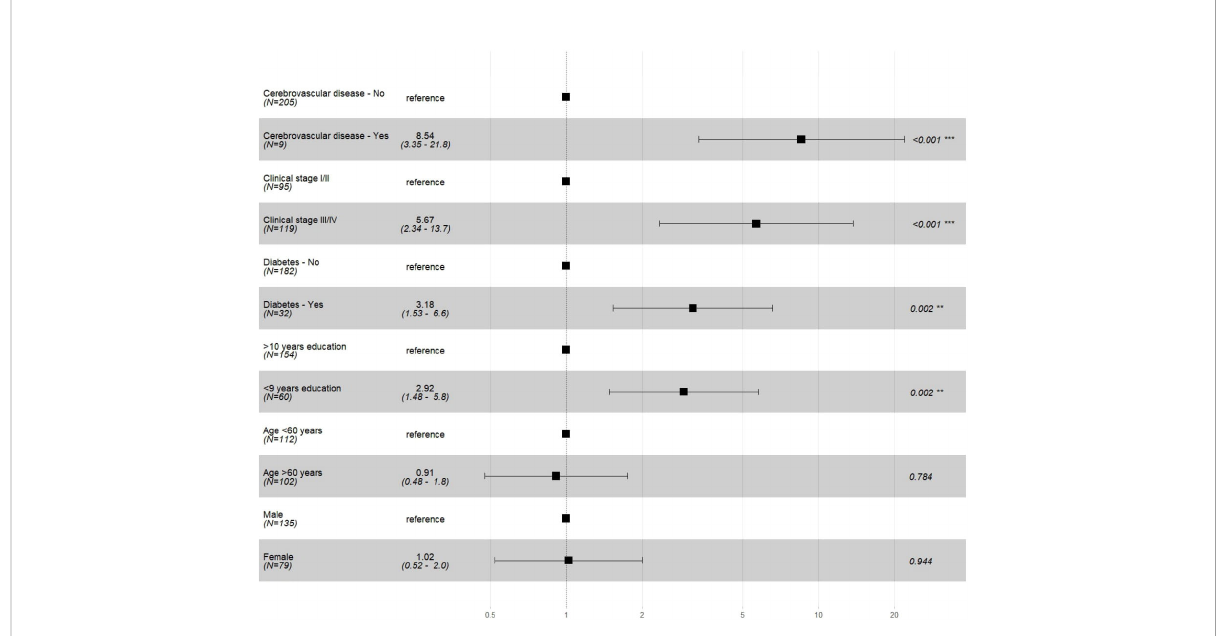
FIGURE 3 Multivariable Cox regression analysis of selected prognostic factors in Gastric Adenocarcinoma cases. * Schoenfeld risk proportionality test of the multiple model p=0.990; model adjusted for variables age and sex.